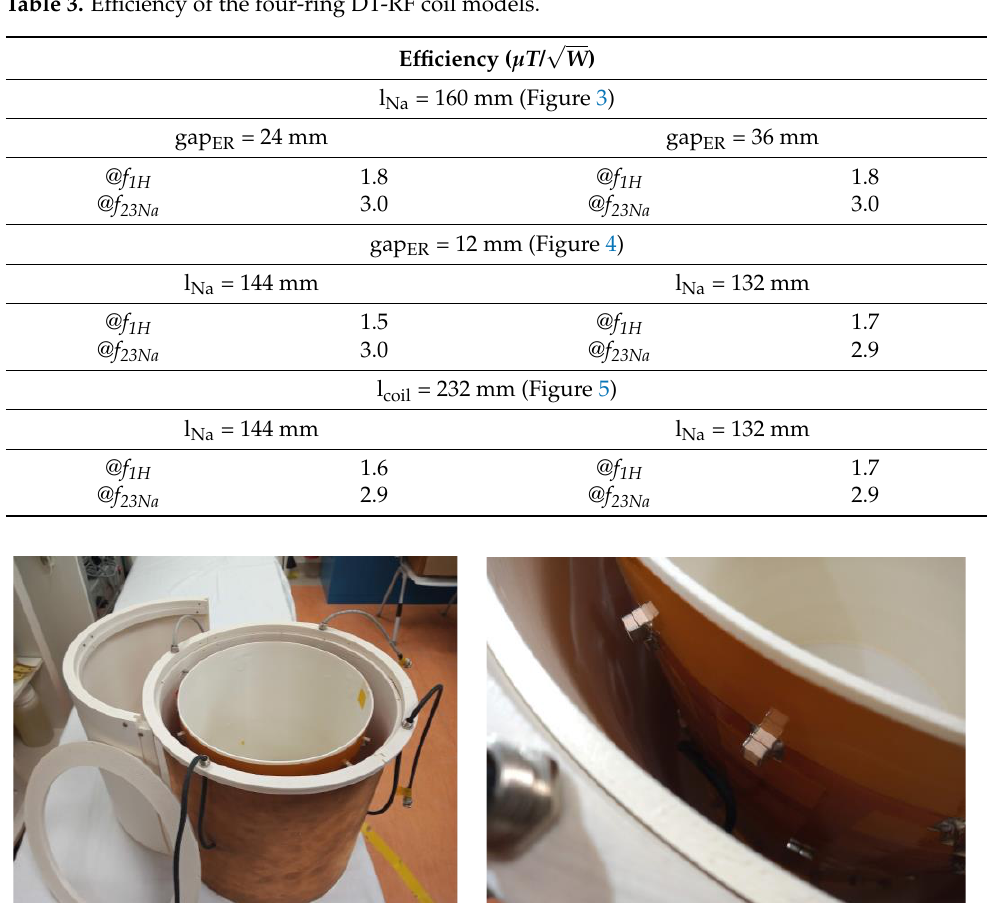
Table 3. Efficiency of the four-ring DT-RF coil models.